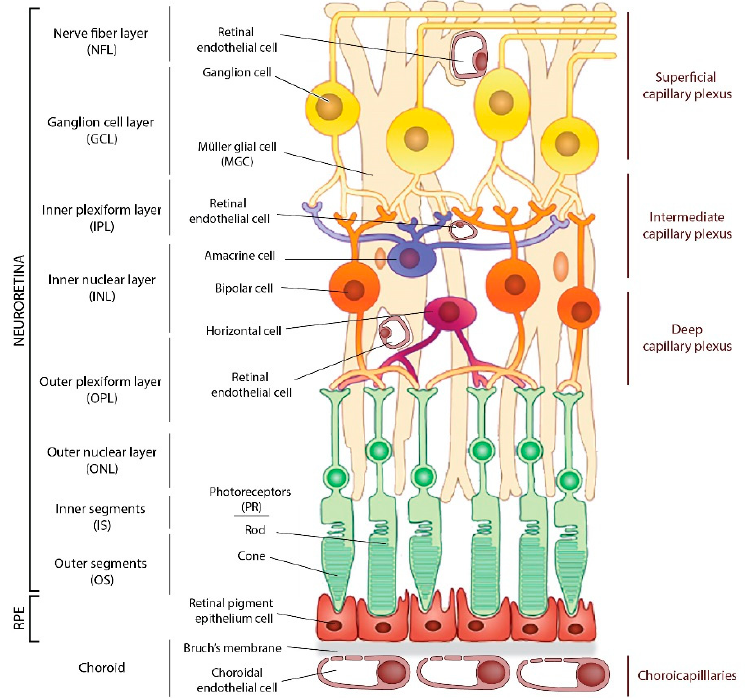
Figure 1. Schematic drawing of the cellular components of the retina. Legend Figure 1: There are three retinal vascular plexuses tightly coordinated with retinal neurons and a choroid plexus underlying RPE. GCL: Ganglion cell layer; NFL: Nerve fiber layer; INL: Inner nuclear layer; IPL: Inner plexiform layer; MGC: Müller glial cell; ONL: Outer nuclear layer; OPL: Outer plexiform layer; OS: Outer segments; IS: Inner segments; PR: Photoreceptors; RPE, retinal pigment epithelium.